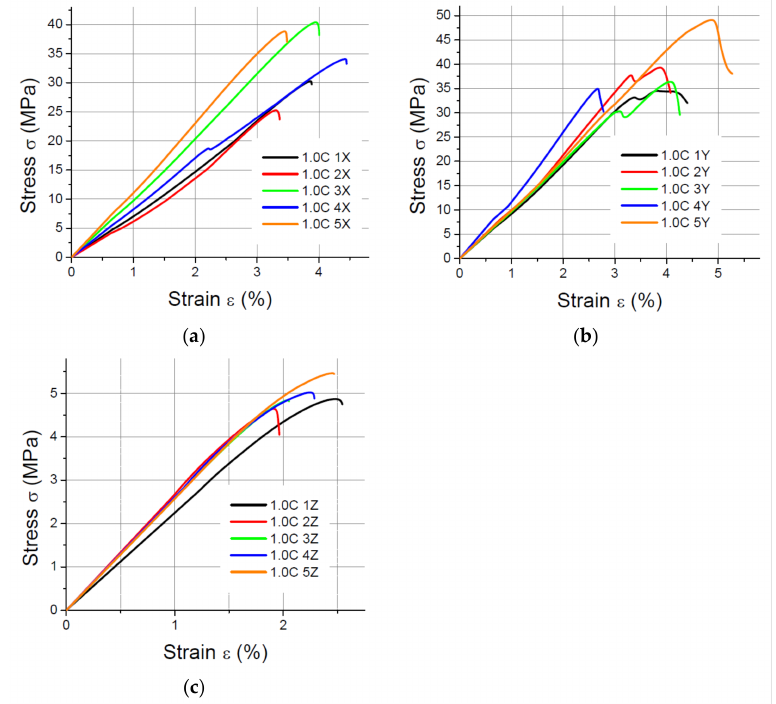
Figure 8. Tensile test results for 1 mm thick specimens made of PLA-CF printed in ( a ) the X orientation;